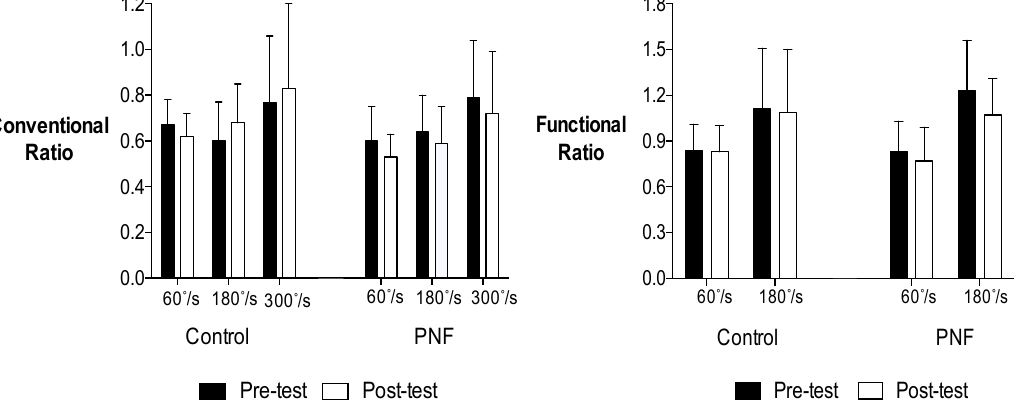
Figure 2. Mean values ± SD of the conventional and functional H:Q ratios for women.